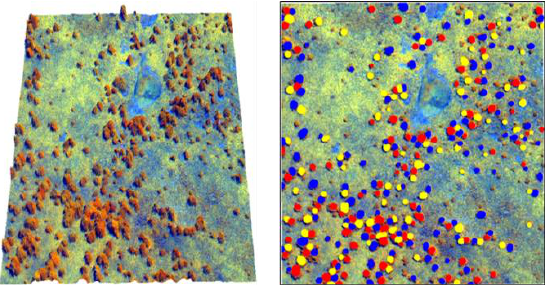
Figure 7. The 3D visualization of the data (left) and the reference masks (color dots) for the prairie area.